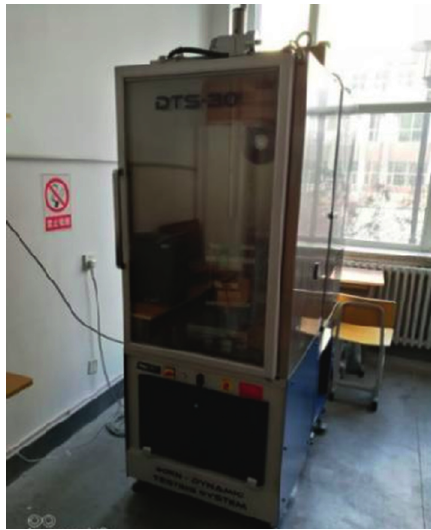
Figure 5: The repeated triaxial